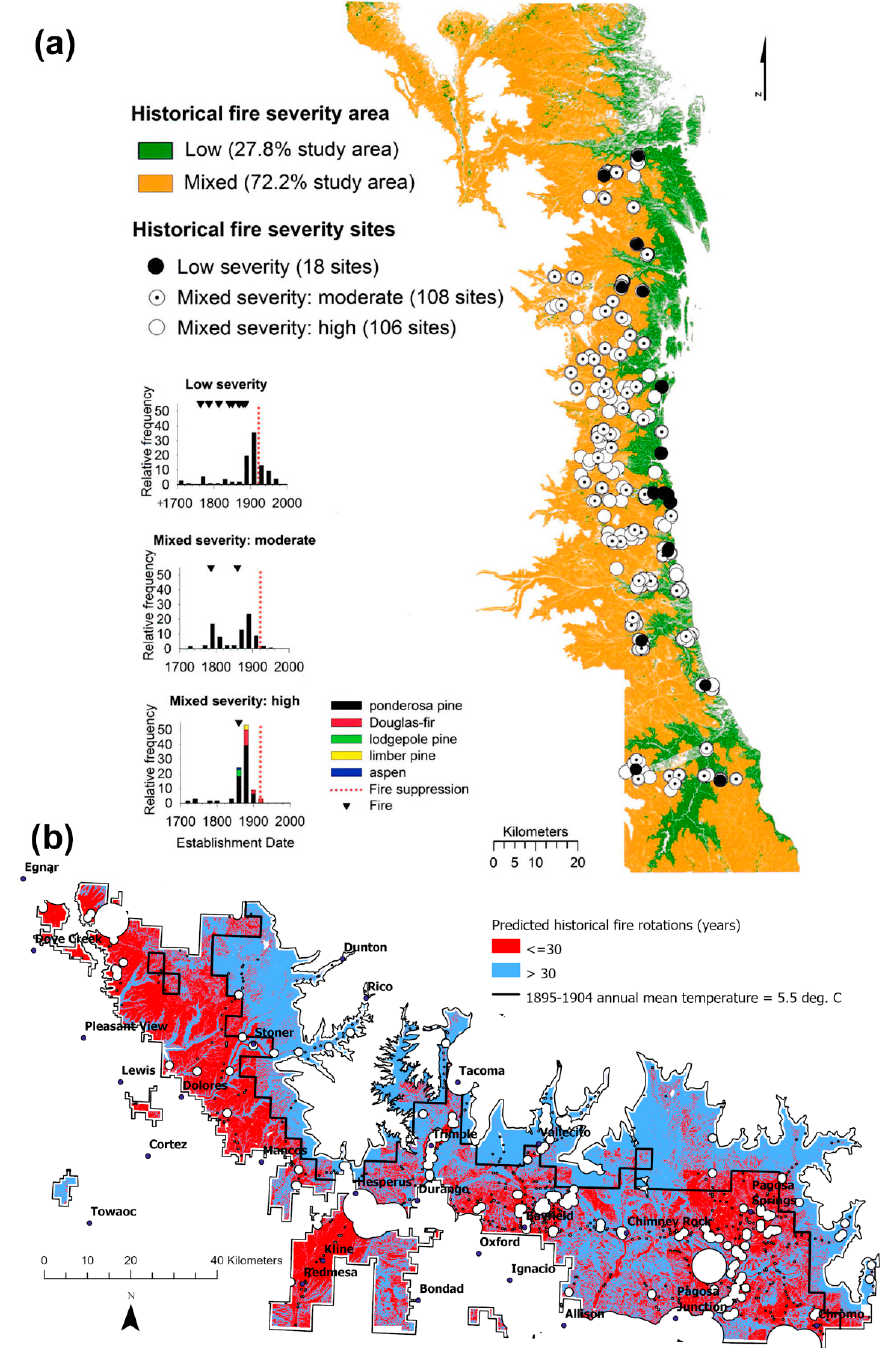
Figure 10. ( a ) “Distribution of 232 sites with historical (pre-1920) evidence of low-severity and mixed-severity fires.” This is a map of the montane zone in the Colorado Front Range, showing on the left the evidence used to classify the fire regime into low or mixed severity at three example sites. The map shows the result of using classification and regression trees (CARTs) to extrapolate from classified sites to map the two fire regimes across the whole landscape using physical predictors (e.g., elevation and slope). Reprinted from ([16] Figure 5) with permission of PLoS One, ( b ) “Relatively frequent fire (all-severity fire rotations ≤ 30 years) versus longer-rotation fire in historical montane forests overlain by the contour for 5.5 °C annual mean temperature between 1895 and 1904, which roughly corresponds with the upper limit of relatively frequent fire.” This map was derived by using random forest modeling of 28 tree-ring-based fire history sampling sites versus 14 topographic, soils, and climate predictors. Reprinted from ([53] Figure 5a) with permission of John Wiley and Sons.